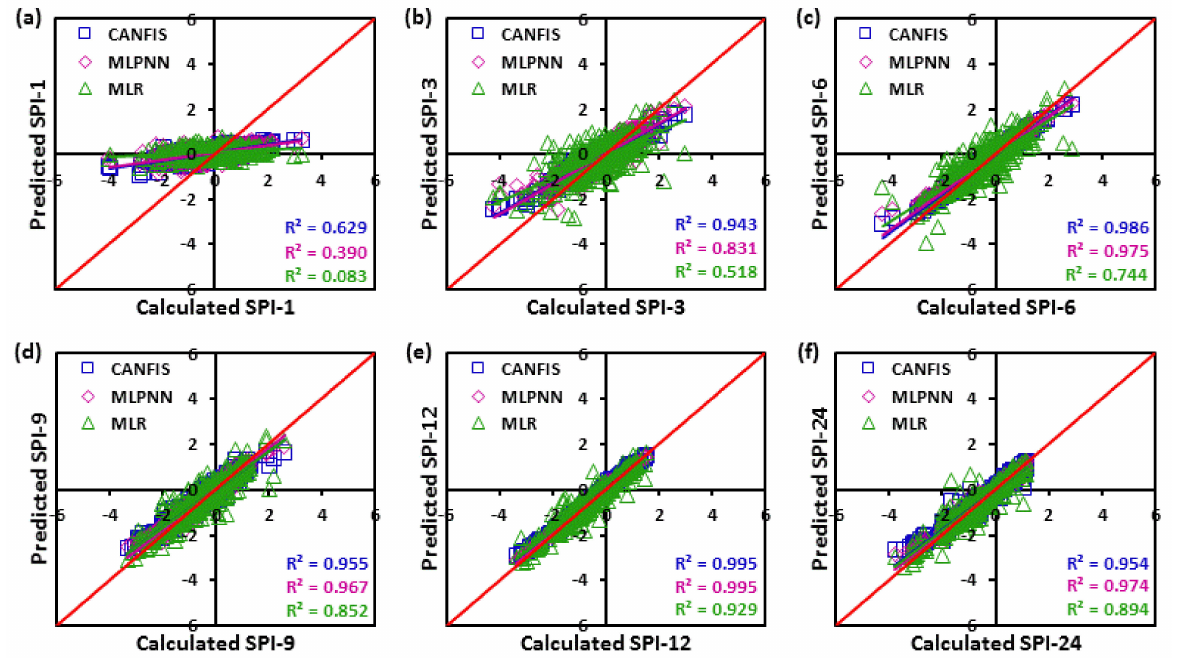
Figure 8. ( a – f ) Scatter plots of calculated and predicted multi-scalar SPI values by CANFIS, MLPNN, and MLR models during the testing period at Rudraprayag station.